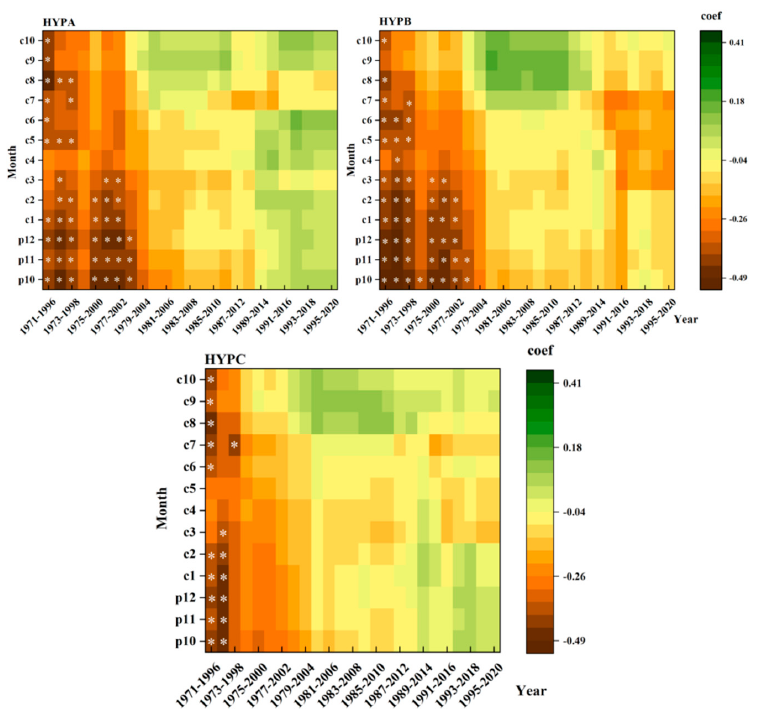
Figure 11. Sliding analysis results of the L. principis-rupprechtii tree-ring width index values derived at different elevations and precipitation from October of the previous year to October of the current year (with a sliding window of 26 years; p represents the previous year; c represents the current year; and the * symbol represents a significant correlation at the 0.05 level).